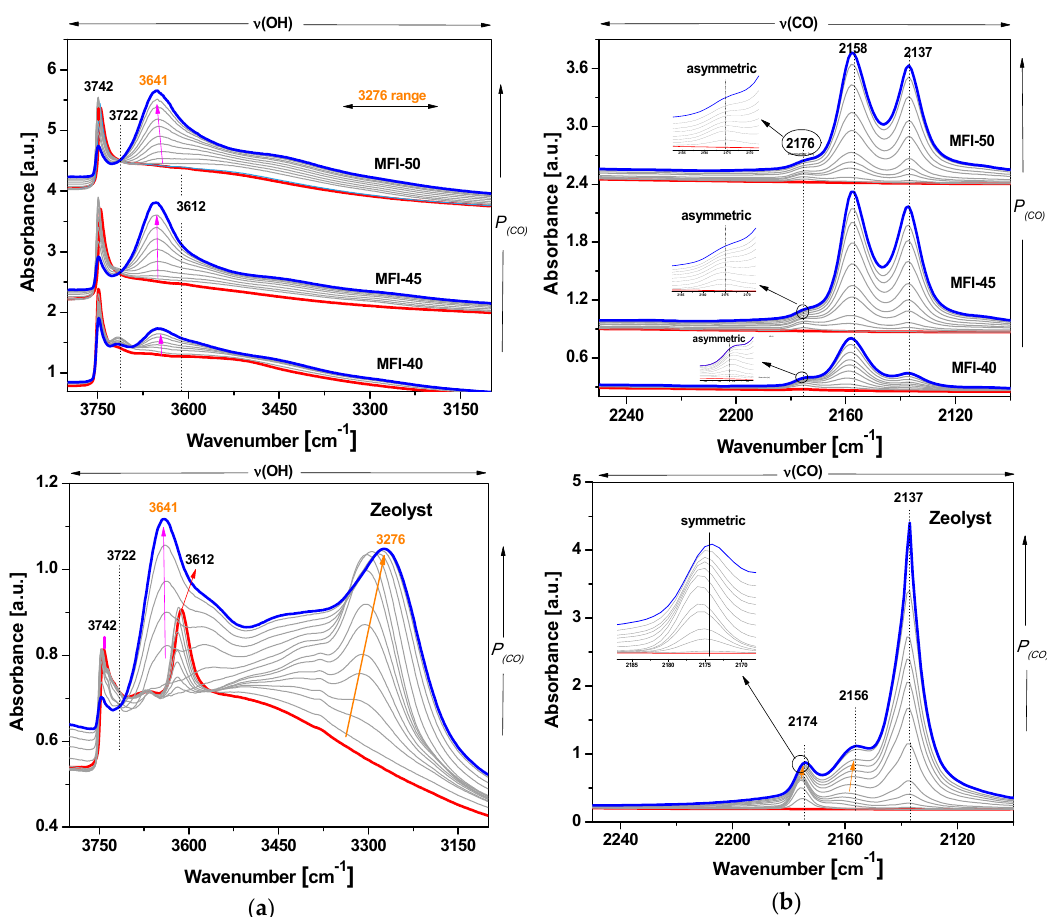
Figure 6. The FT-IR spectra after CO adsorption for synthesized H-ZSM-5 and Zeolyst samples; ( a ) in the range of 3800–3100 cm − 1 , and ( b ) in the range of 2250–2100 cm − 1 .